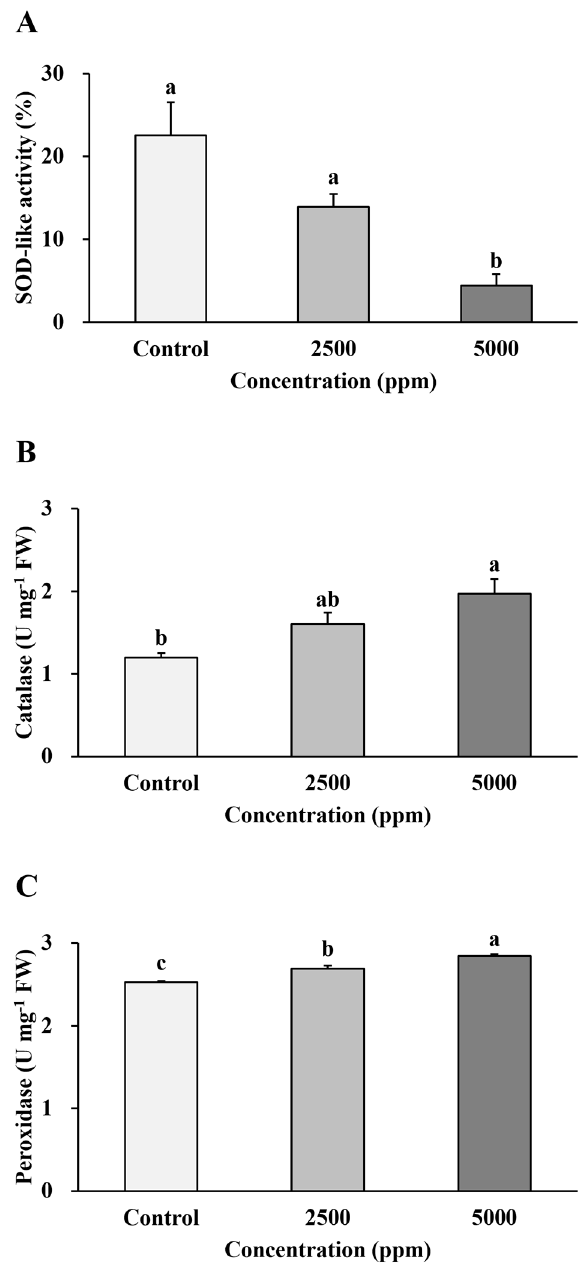
Figure 9. Effect of SCE treatment on the antioxidant content of Festuca arundinacea ( A ) SOD, ( B ) CAT, and ( C ) POD. Error bars represent standard deviations. Each data point represents the mean of at least six replications. Bars with different letters are significantly different from each other at p ≤ 0.05.